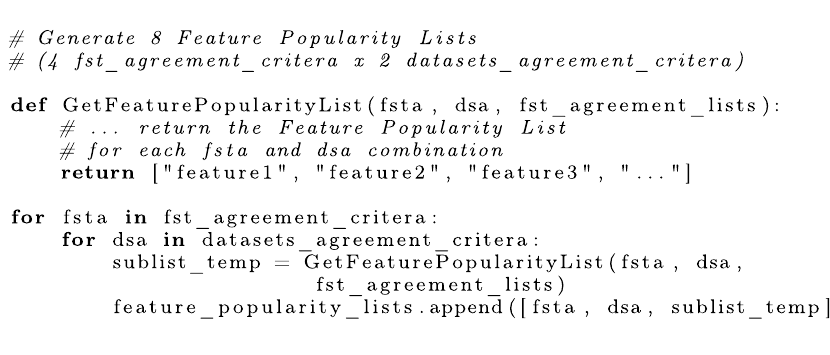
Table 10 Jaccard similarities by dataset for FST Agreement Lists where 5/7 FSTs Agree ( fst A